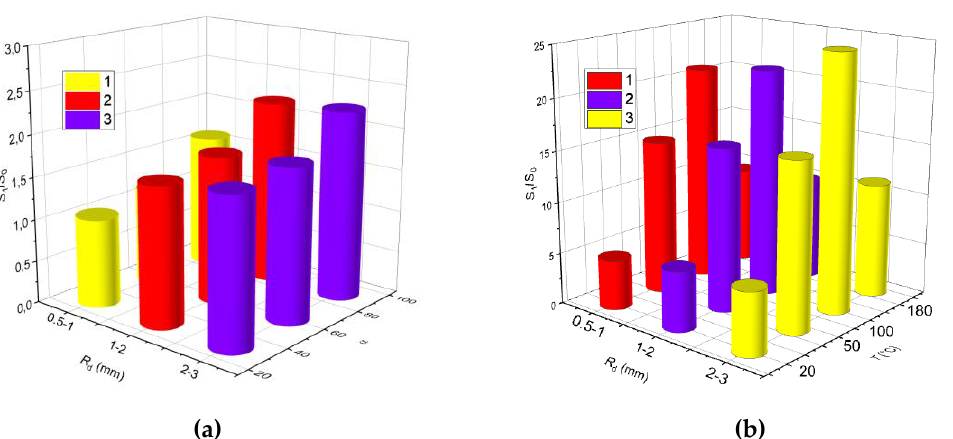
Figure 13. S 1 / S 0 vs. R d vs. ɑ d ( a ); S 1 / S 0 vs. R d vs. T ( b ): 1 — R d = 0.5 – 1 mm; 2 — R d = 1 – 2 mm; 3 — R d = 2 – 3 mm.